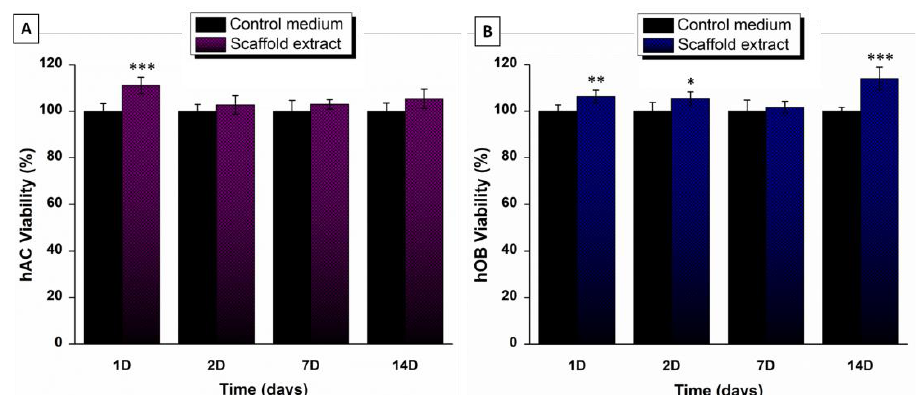
Figure 6. Cytotoxicity indirect assay on hACs ( A ) and hOBs ( B ) with scaffold extracts collected after 1, 2, 7 and 14 days in PBS of pH 7.4 at 37 °C. Values represent mean ± SD (n = 8). ANOVA test was performed between results of studied extracts with respect to control (basal medium) at each time point (* p < 0.05, ** p < 0.005, *** p < 0.001).